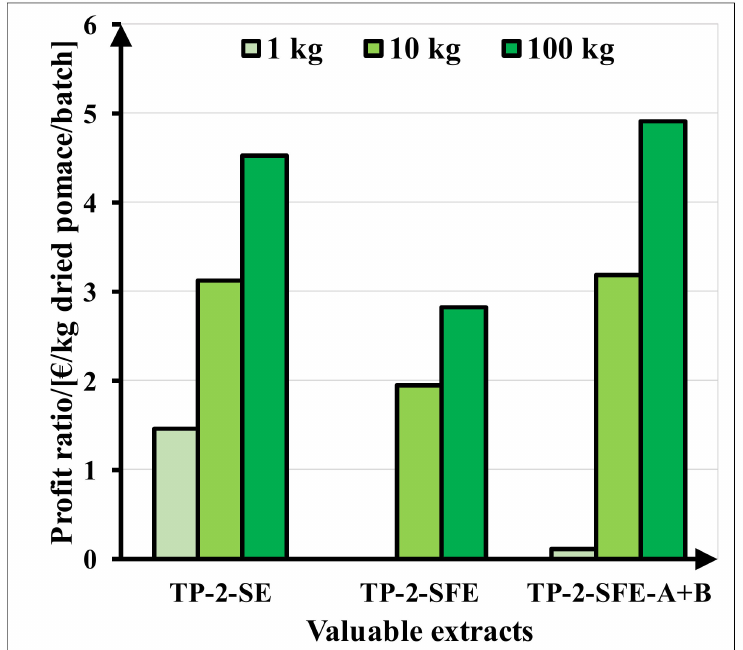
Figure 9. Profit ratio estimation for four valuable extracts (TP-2-SE, TP-2-SFE, TP-2-SFE-A and TP-2-SFE-B) and three scale-up capacities (1:10:100 kg dried pomace/batch). For plants with small capacity (1 kg dried pomace/batch), the SE process is more profitable (profit ratio between 1.46 and 4.52 € /kg dried tomato pomace/batch). Increasing the processing capacity of the plant (100 kg dried pomace/batch), the SFE process becomes ratio 4.92 € /kg dried tomato